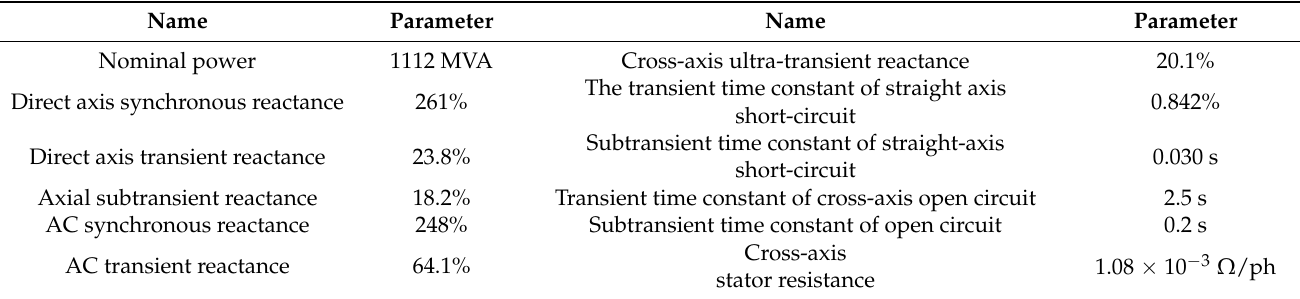
Table 3. TQFSN-1000-2 synchronous generator module’s input parameters.